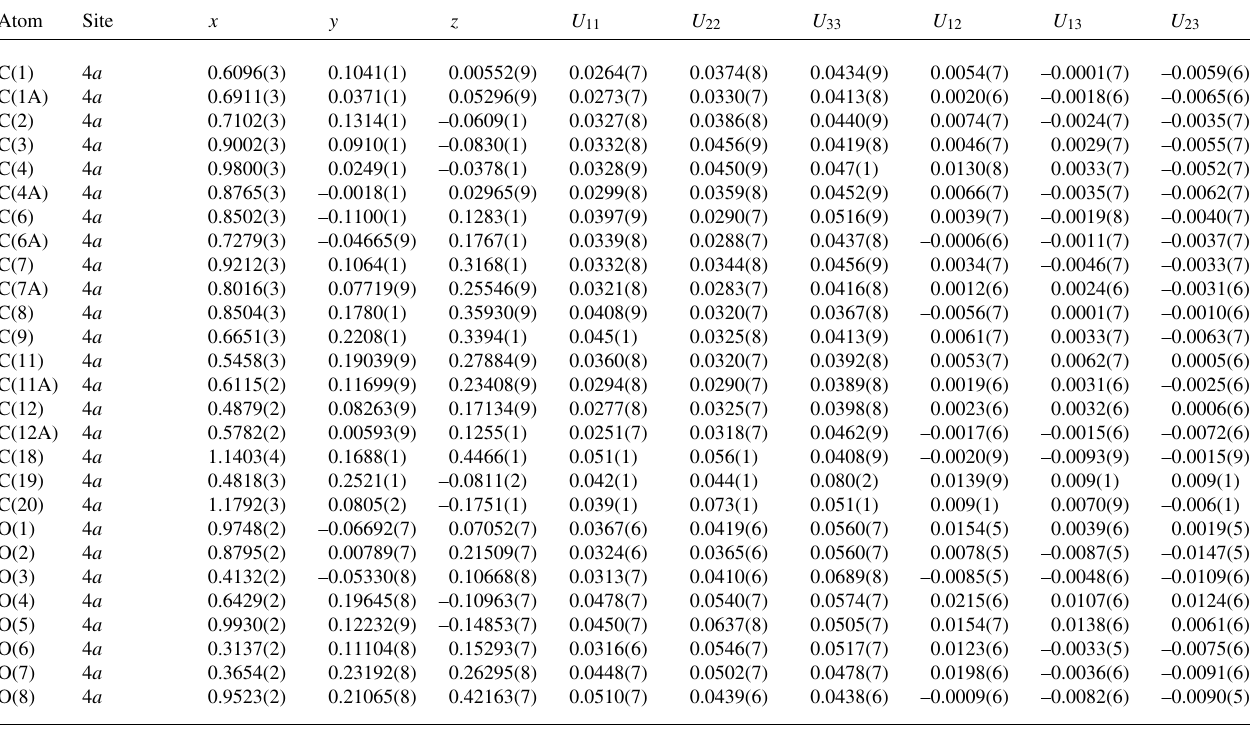
Table 3. Atomic coordinates and displacement parameters (in Å 2 ) .